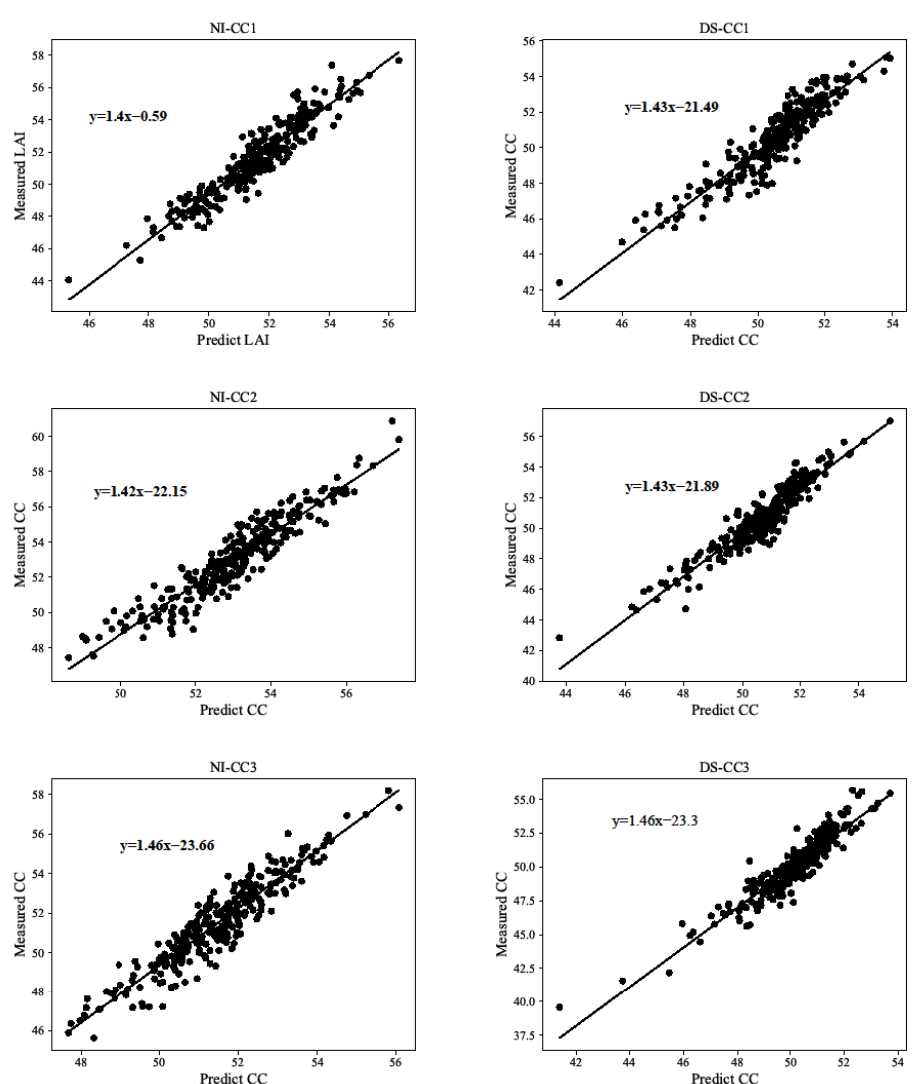
Figure 3. The relationship between the predicted and the measured chlorophyll content (CC) values at three wheat growth stages, heading (CC1), flowering (CC2), and filling (CC3), under normal irri- gation (NI) and drought stress (DS) conditions.